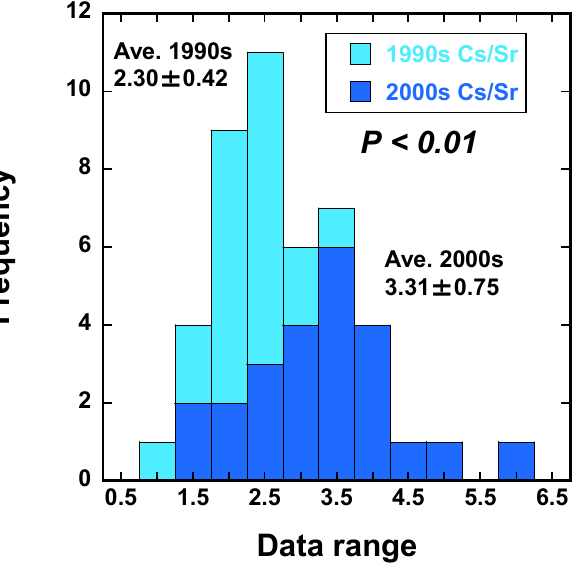
Fig. 5. Frequency distribution of the 137 Cs/ 90 Sr activity ratio in the monthly atmospheric depositions at the MRI in Tsukuba during spring in the 1990s and 2000s. The decade averages of the two data sets are significantly different ( P < 0.01 )